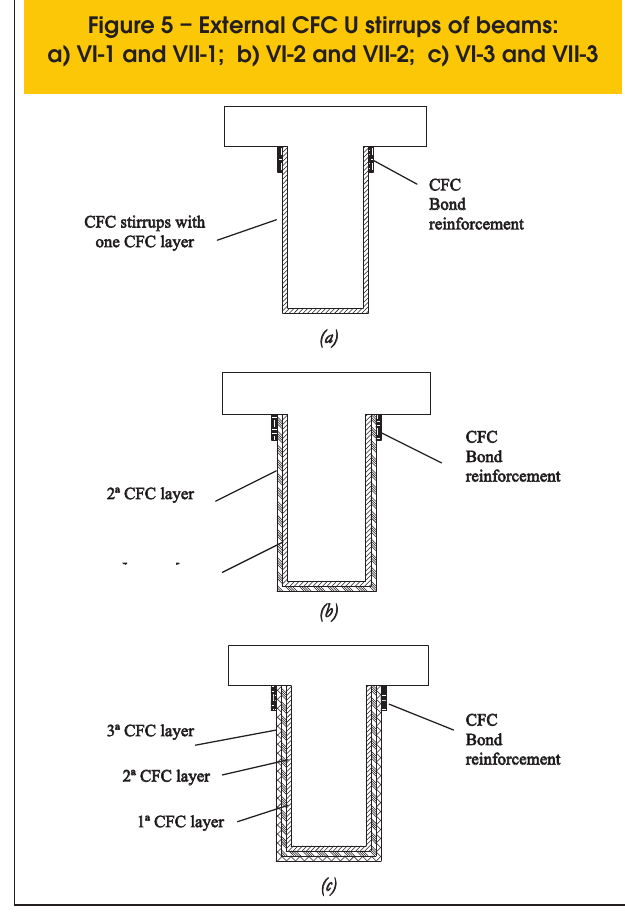
Figure 5 – External CFC U stirrups of